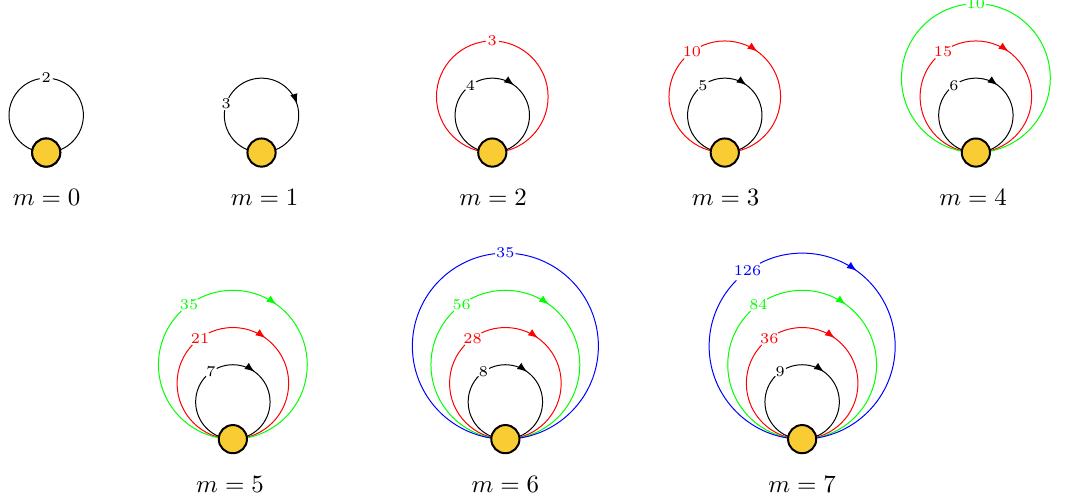
Figure 4. Quivers for C m +2 . The multiplicities of (cid:12)elds, i.e. the dimensions of the representations for the SU( m + 2) global symmetry, are indicated on the arrows. For m even, the multiplicity of the outmost (unoriented) line is half the dimension of the corresponding representation. Black, red, green, blue and purple arrows represent (cid:12)elds of degree 0, 1, 2, 3 and 4, respectively. Periodic